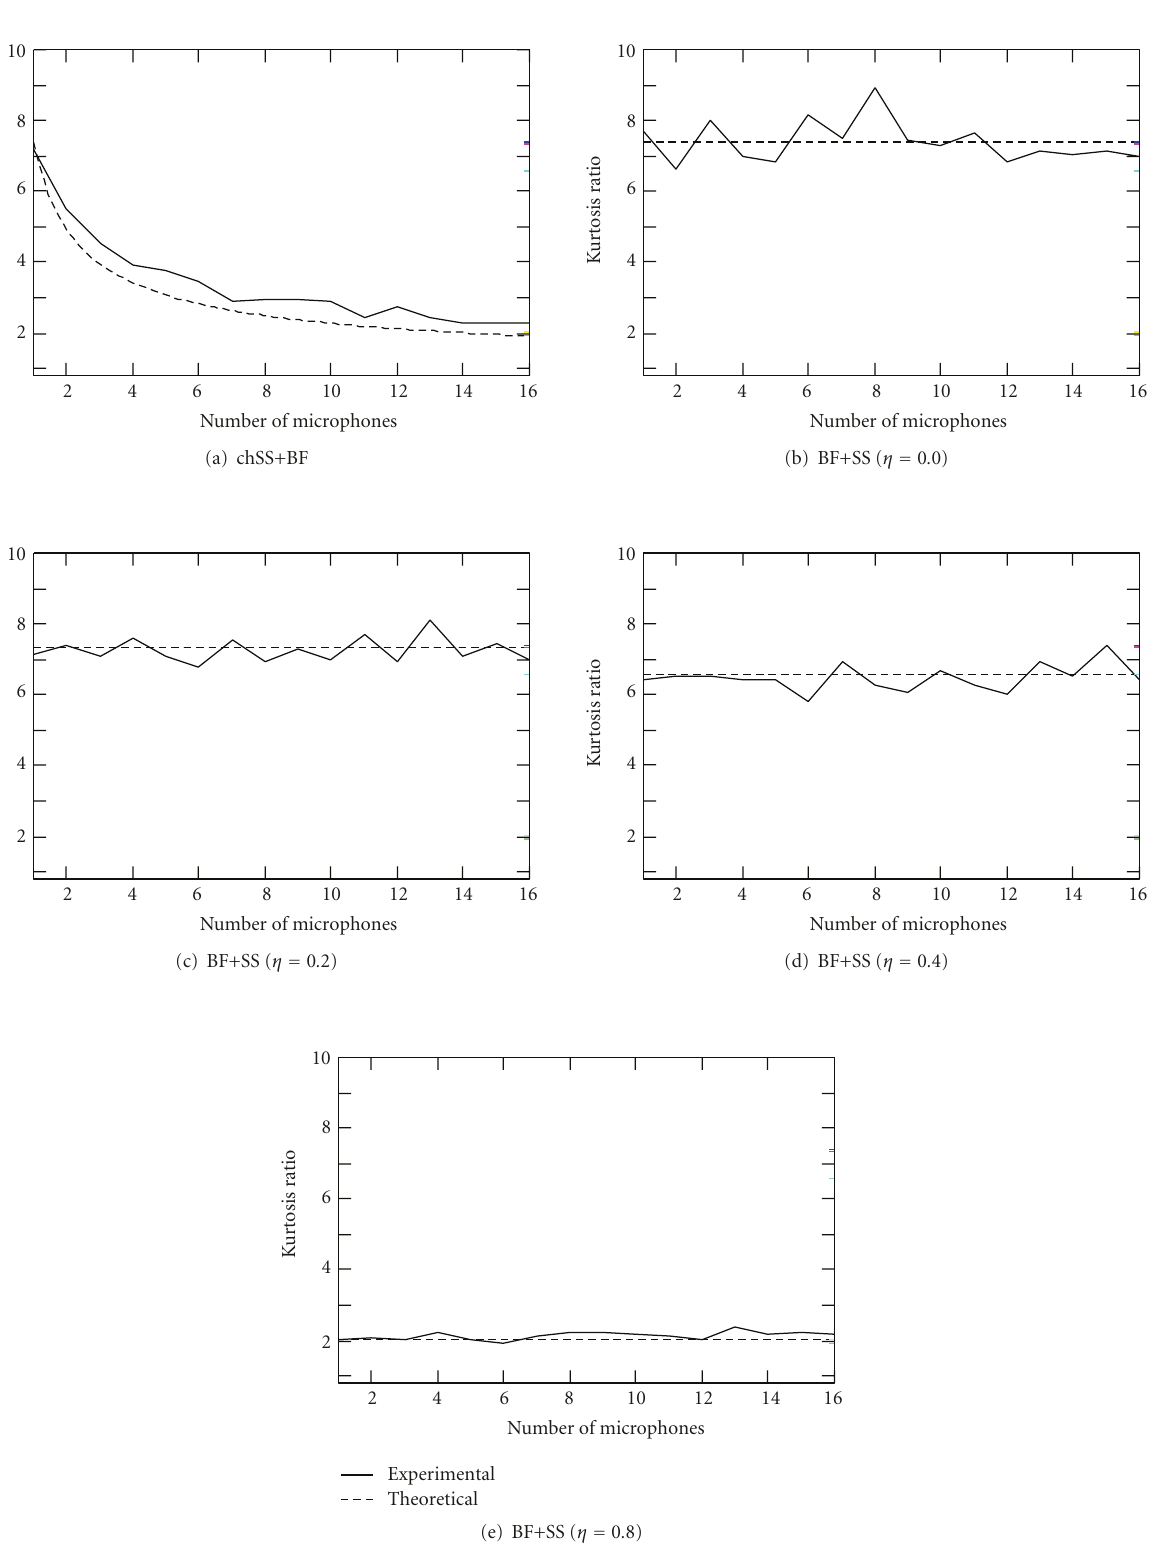
Figure 16: Comparison between experimental and theoretical kurtosis ratios for Gaussian input